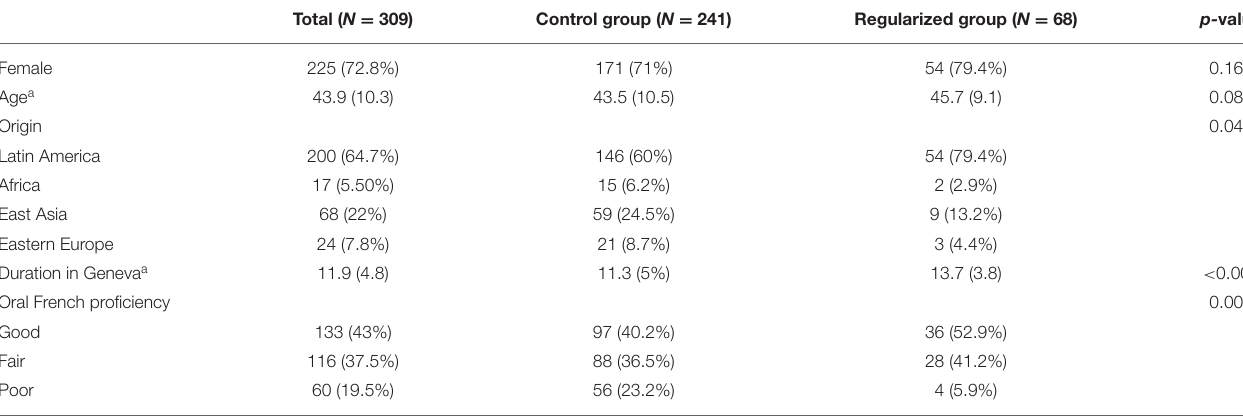
TABLE 1 | Sociodemographic characteristics of the study participants, stratified by residence status ( N =